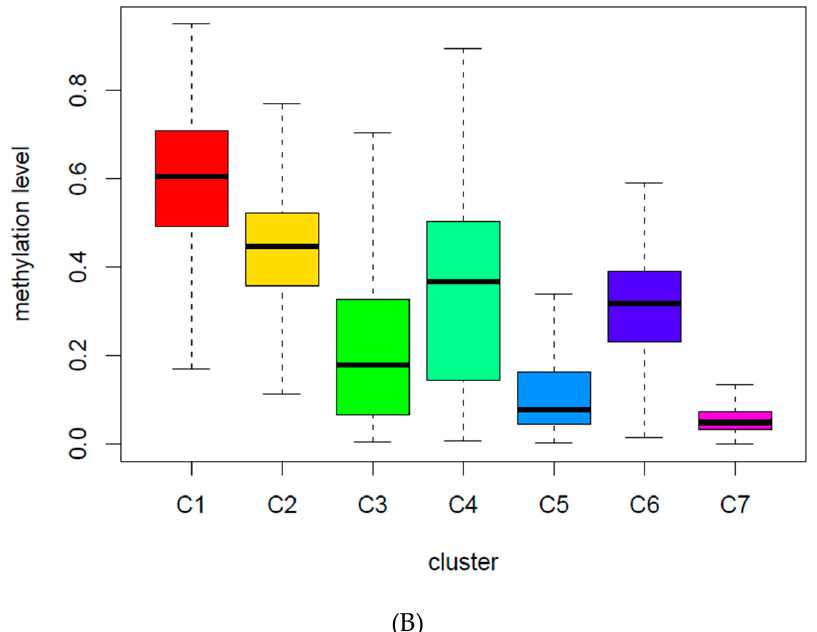
Figure 8. ( A ) Heatmap of methylation sites in different gastric cancer subtypes grouped by matrix L. The heat rectangle on the left map is red if there is a statistically significant difference between the selected cluster and the other clusters; otherwise, it is blue. Sig, significance, p < 0.05; No, no significance. ( B ) The box-plot of methylation levels of these seven clusters.